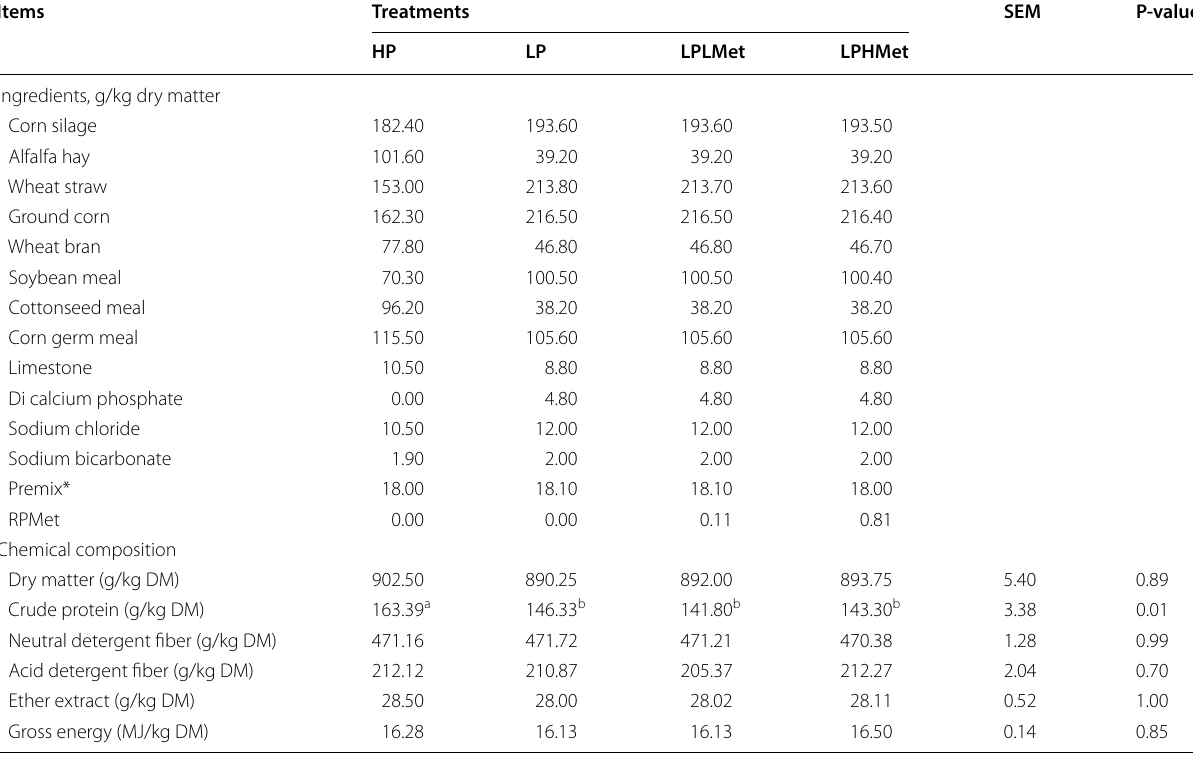
SEM, standard error of the mean a,b Superscripts values within the same row, are significantly different at (P < 0.05)